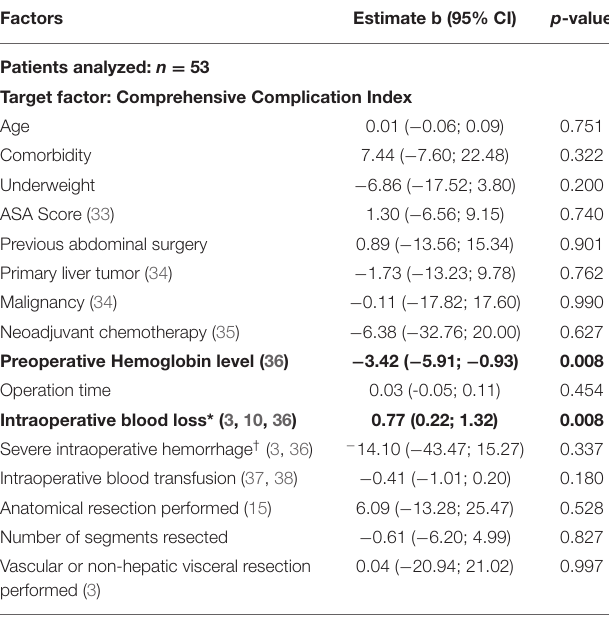
TABLE 5 | Multivariable regression analysis for the endpoint Comprehensive Complication